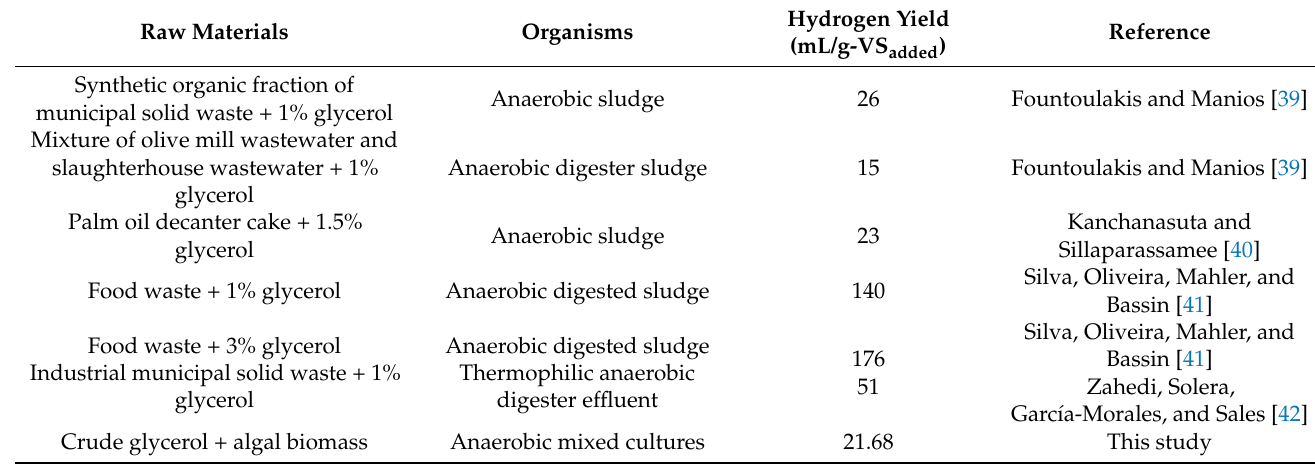
Table 4. Comparison of hydrogen yields from this study with those reported in the